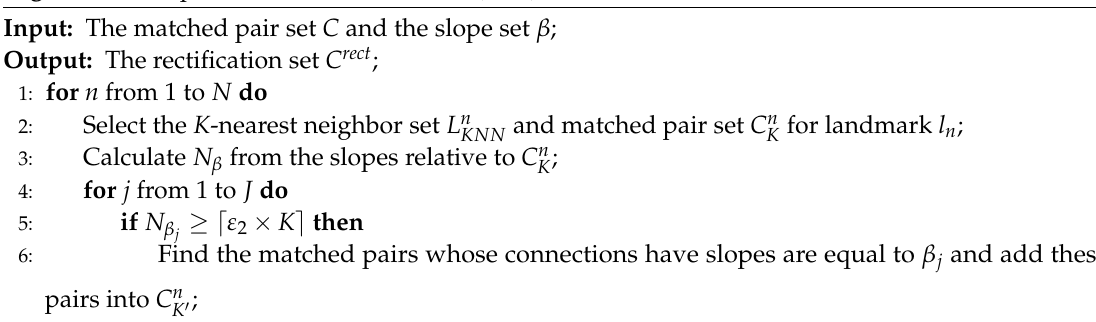
Algorithm 2 Slope-Restricted Rectification